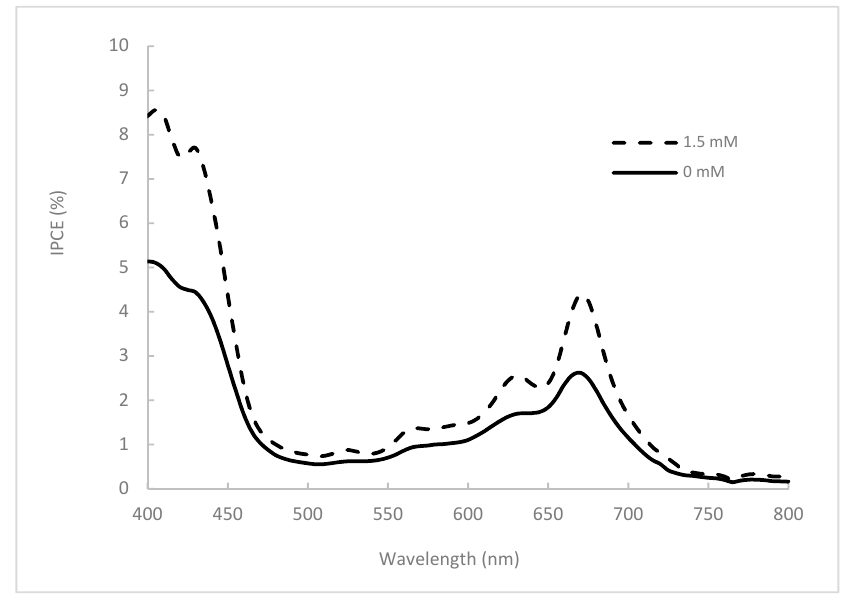
Figure 4. Incident photon-to-current efficiency (IPCE) spectra of all-solid state DSSCs sensitized with M2 in the presence/absence of co-adsorbent.